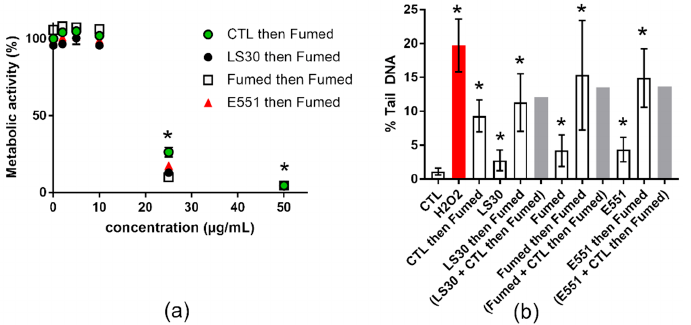
Figure 5. Cyto- and genotoxicity of SiO 2 particles, repeated exposure followed by acute exposure to Fumed SiO 2 . ( a ) Cell metabolic activity impairment after repeated exposure to 1 µg/mL SiO 2 particles (CTL or LS30 or Fumed SiO 2 ), followed by 24 h exposure to 2, 5, 10, 25, or 50 µg/mL of Fumed silica. ( b ) Genotoxicity assessed via alkaline comet assay, on RAW 264.7 cells exposed repeatedly to 1 µg/mL SiO 2 particles, three times per week for three weeks, followed by a single acute exposure to 10 µg/mL Fumed SiO 2 for 24 h. Mean ± standard deviation of five replicates (WST-1) and three comet experiments performed independently, with three slides per experiment. Statistical significance: * p < 0.05, CTL vs.